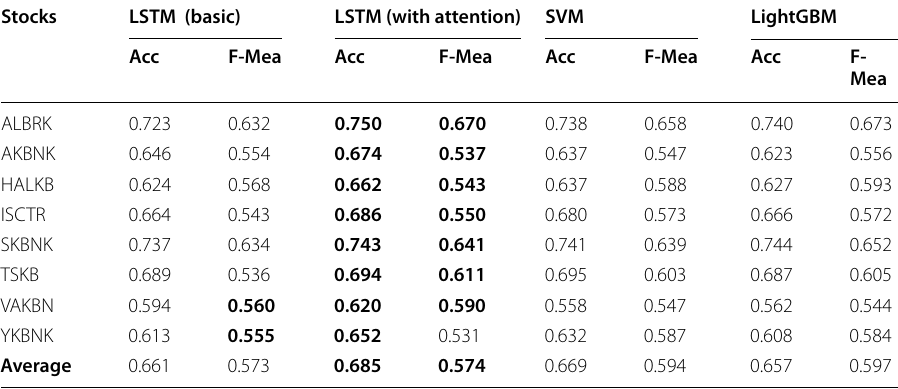
Bold numbers indicate the best performance